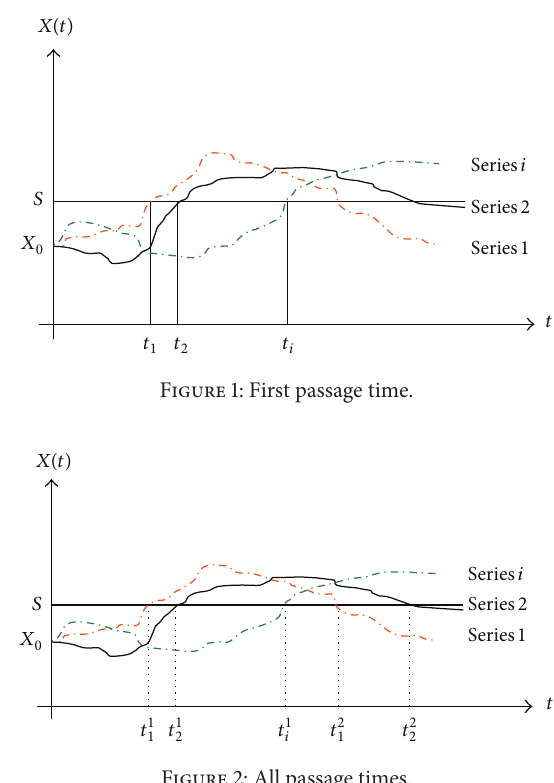
Figure 2: All passage